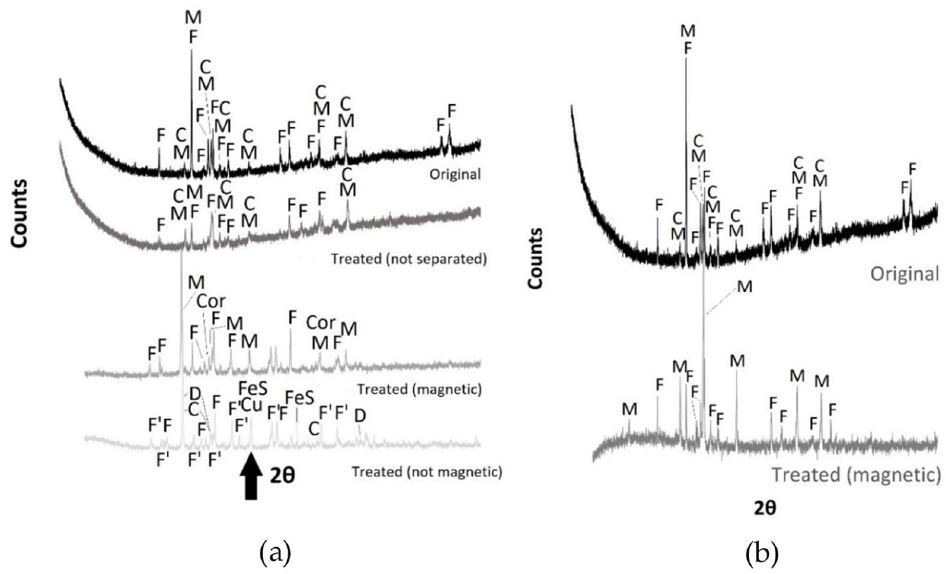
Figure 12. ( a ) Specimen CuCon1 (C, CuFe 2 O 4 ; F, Fe 2 SiO 4 ; M, Fe 3 O 4 and all the iron spinel; Cu, metallic copper; F’, Fe 0 . 92 Mg 1 . 08 O 4 S; D, CaMg(SiO 3 ) 2 ; FeS). ( b ) Specimen CuCon3 (C, CuFe 2 O 4 ; F, Fe 2 SiO 4 ; M, Fe 3 O 4 and all the iron spinel).